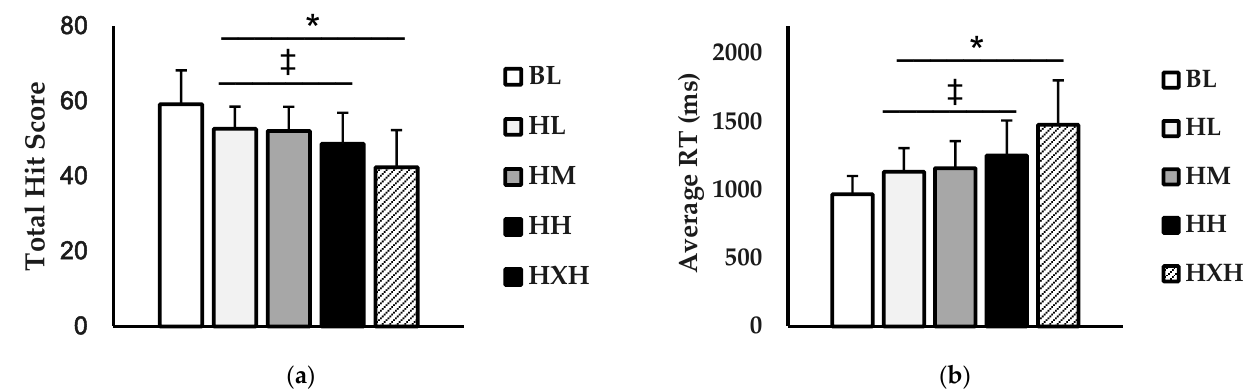
Figure 3. Comparison of ( a ) hit score, ( b ) peripheral reaction time (ms) between baseline (BL; white), helmet + light facemask (HL; light grey), helmet + medium facemask (HM; grey), helmet + heavy (HH; black), and helmet + extra heavy (HXH; black striped) conditions. Data are presented as mean ± SD. * indicates significant difference from baseline ( p < 0.05). ‡ indicates significant difference from HXH ( p < 0.05).